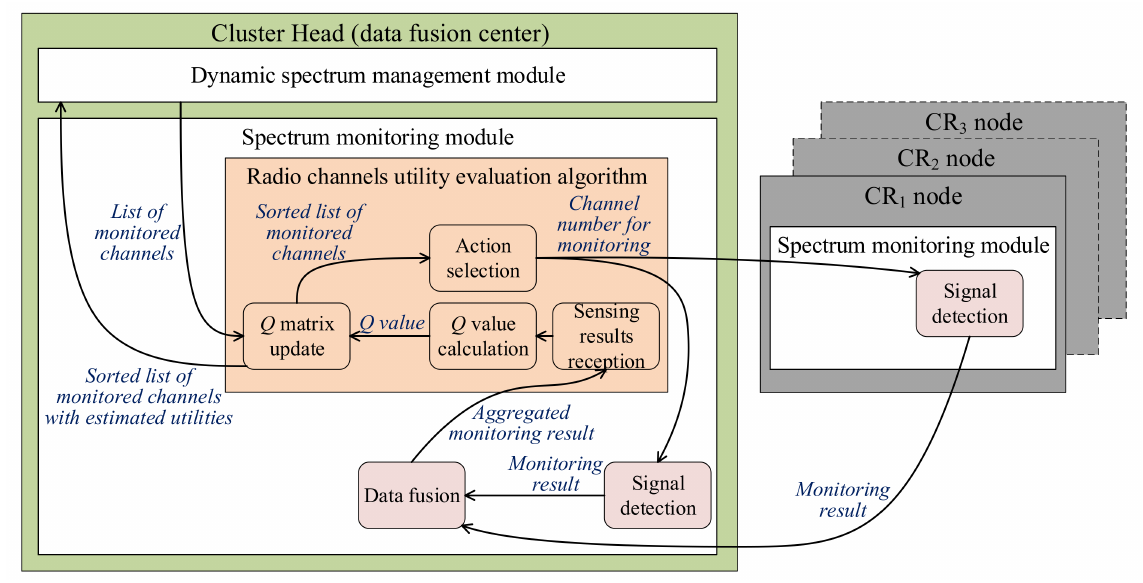
Figure 5. Cooperative spectrum monitoring using the centralized version of the radio channels utility evaluation